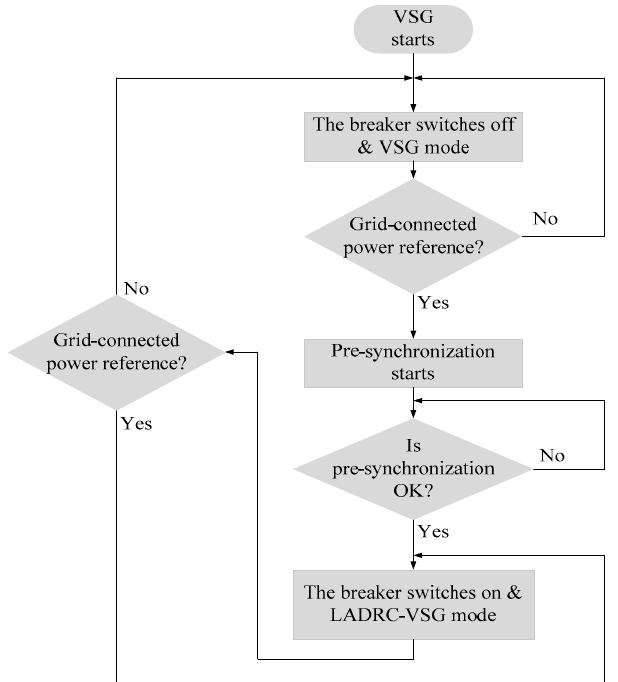
Figure 14. The procedure of the operation of linear active disturbance rejection control-virtual synchronous generator (LADRC-VSG).